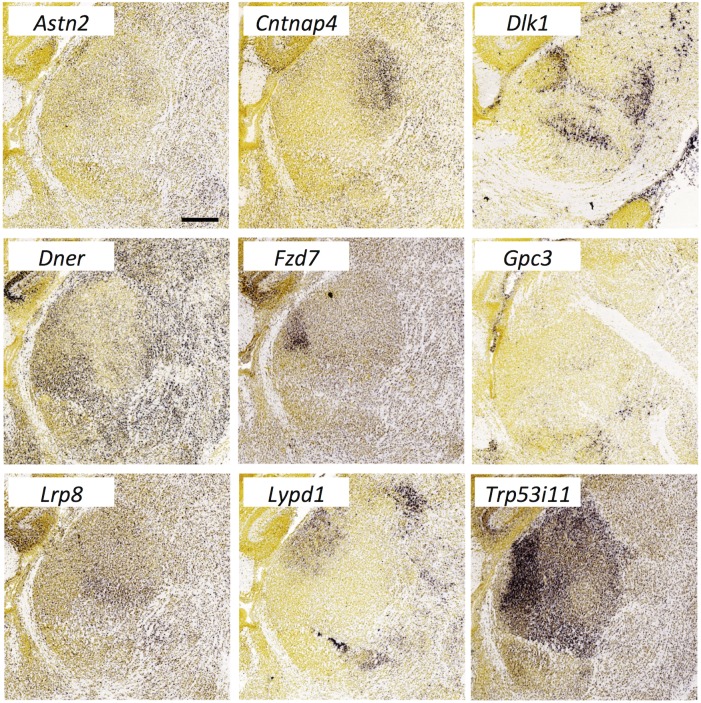
Expression of genes encoding miscellaneous surface or secreted molecules in the thalamus at E18.5.In situ hybridization data from sagittal sections of the thalamus at E18.5 obtained from the devABA revealed differential patterns of expression of Astrotactin2 (Astn2), Contactin-associated protein-4 (Cntnap4), Delta-like-1 homolog (Dlk1), Delta/Notch-Like EGF Repeat Containing (Dner), Frizzled7 (Fzd7), Glypican-3 (Gpc3), Low-density lipoprotein receptor 8 (Lrp8), LY6/PLAUR Domain Containing 1 (Lypd1) and Trp53i11. See text for details. A representative and equivalent section is shown for each molecule (see S8 Fig for details on how the sections were selected). Dlk1 expression is shown laterally, while the other gene expression patterns are shown medially with Gpc3 more medial than the rest (parasagittal). Scale bar in Astn2: 314 μm.